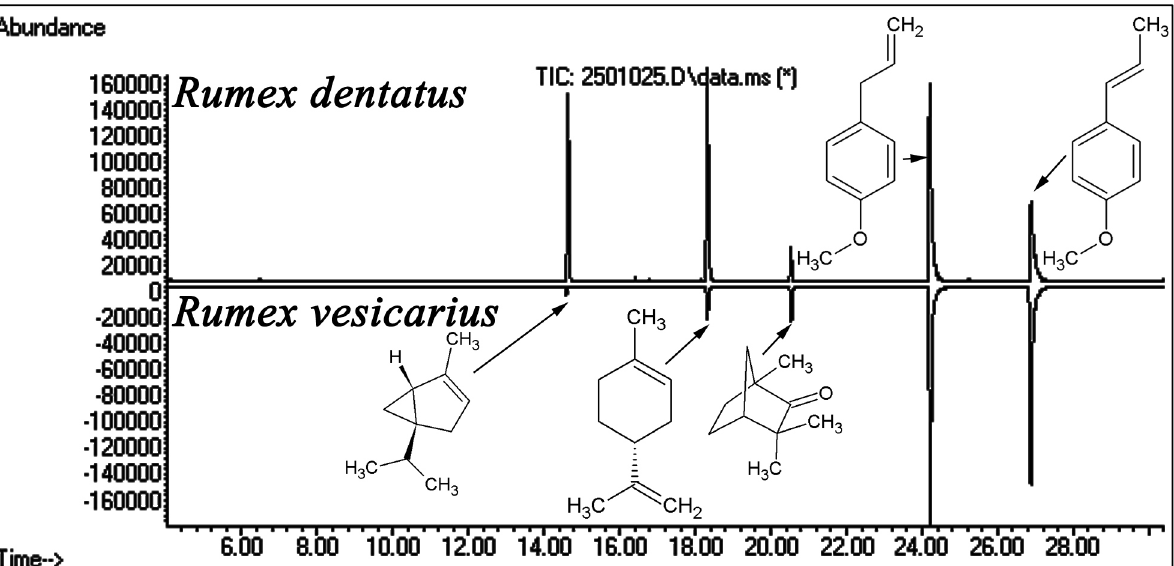
Figure 2. Total ion chromatograms (GC/MS) of the essential oil of Rumex dentatus and Rumex vesicarius . Compounds identification is shown in Table